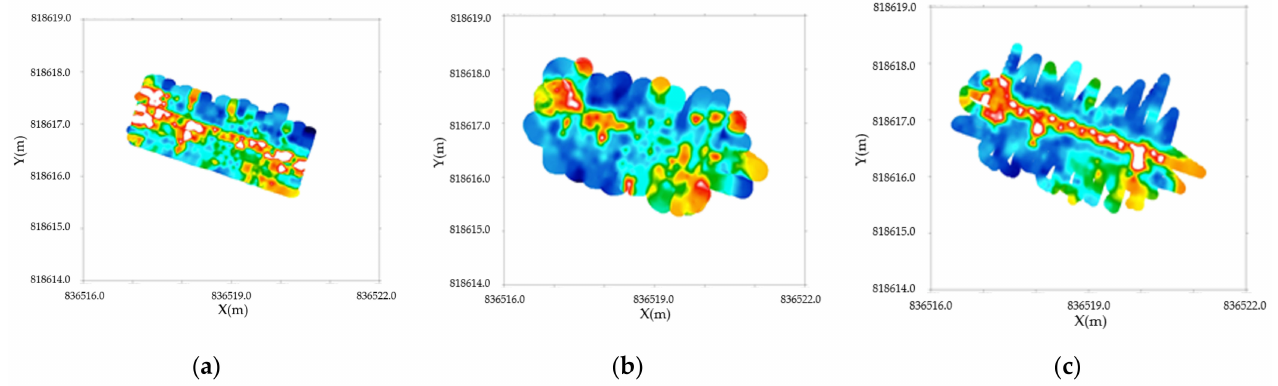
Figure 13. ( a – c ) C-scans for methods T1, T2, and T3,